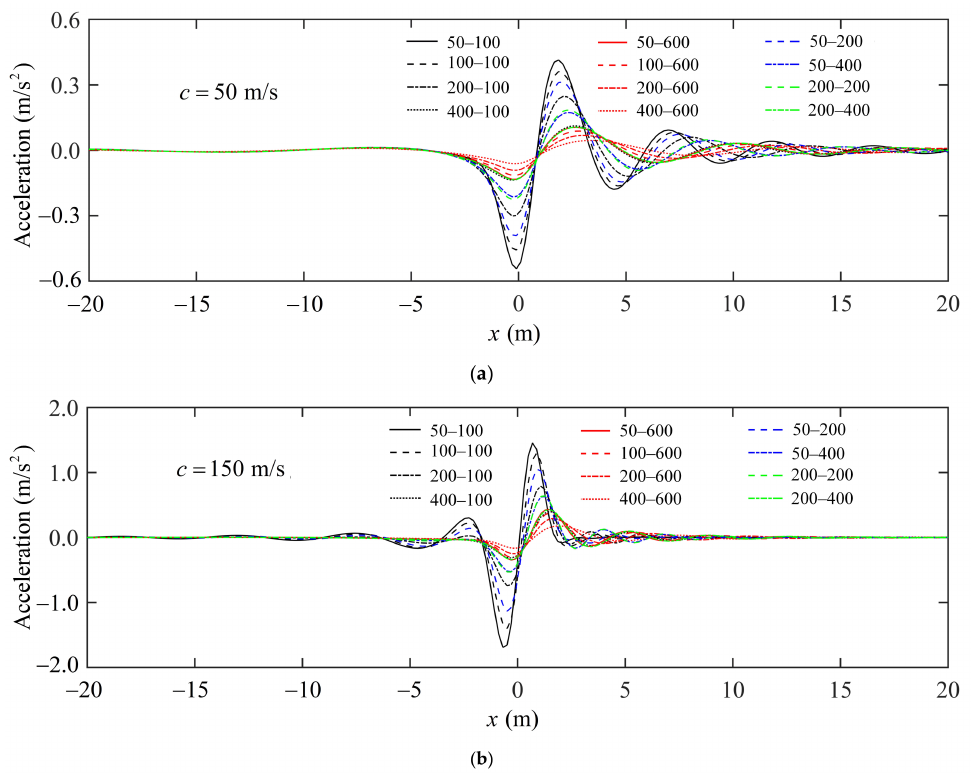
Figure 13. Effect of layer thickness on the vertical velocity fluctuation amplitude along the x -axis, induced by a moving Gaussian load with speeds of ( a ) c = 50 m/s and ( b ) c = 150 m/s.